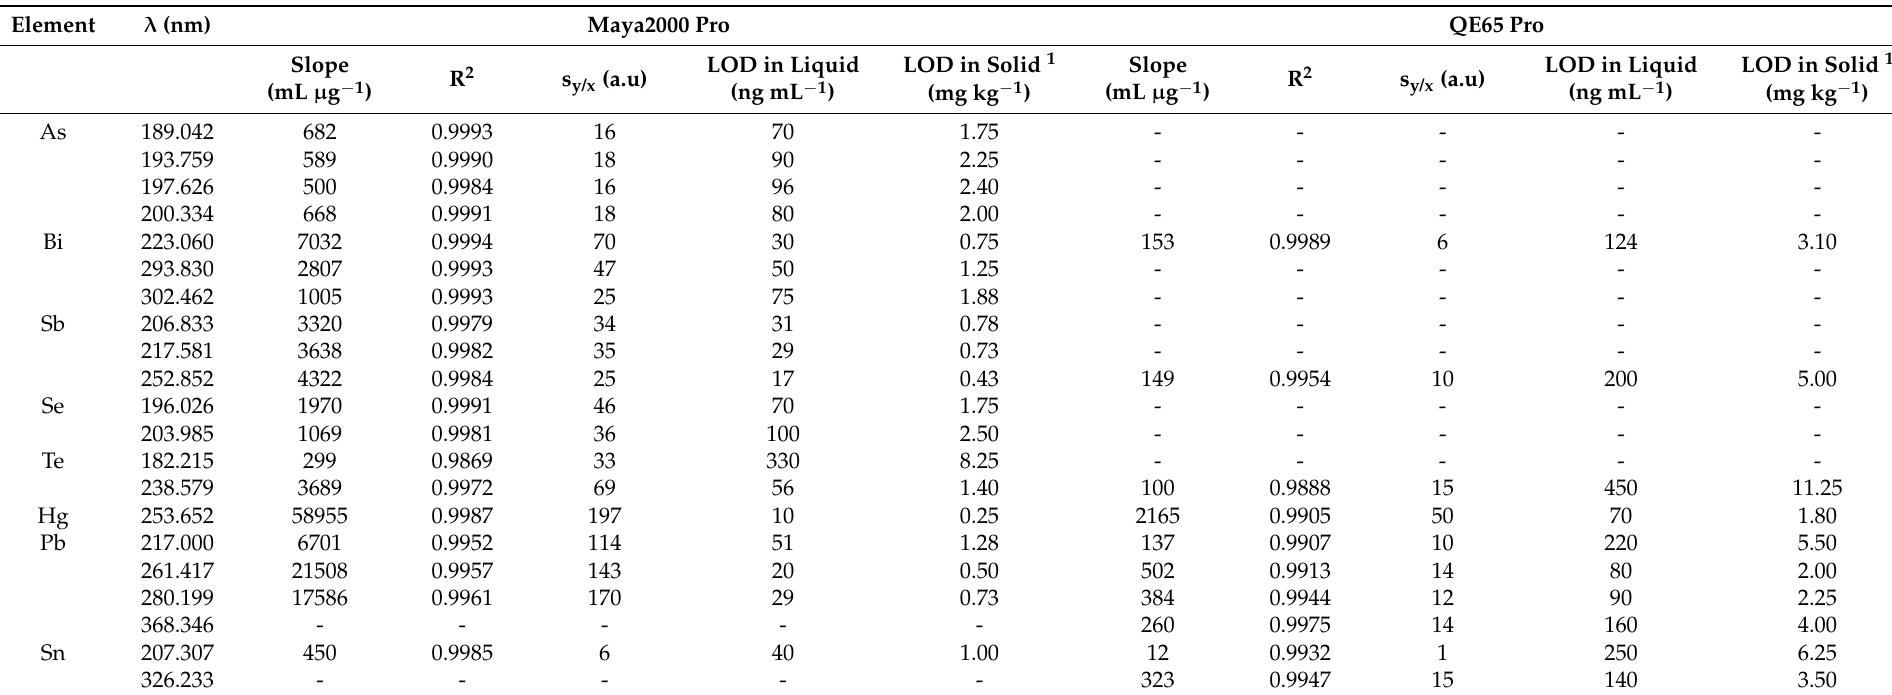
Table 3. Parameters of the calibration curves and LOD in liquid and solid samples by the SSETV- µ CCP-OES method using Maya2000 Pro and QE65 Pro microspectrometers for peak height measurement of transient